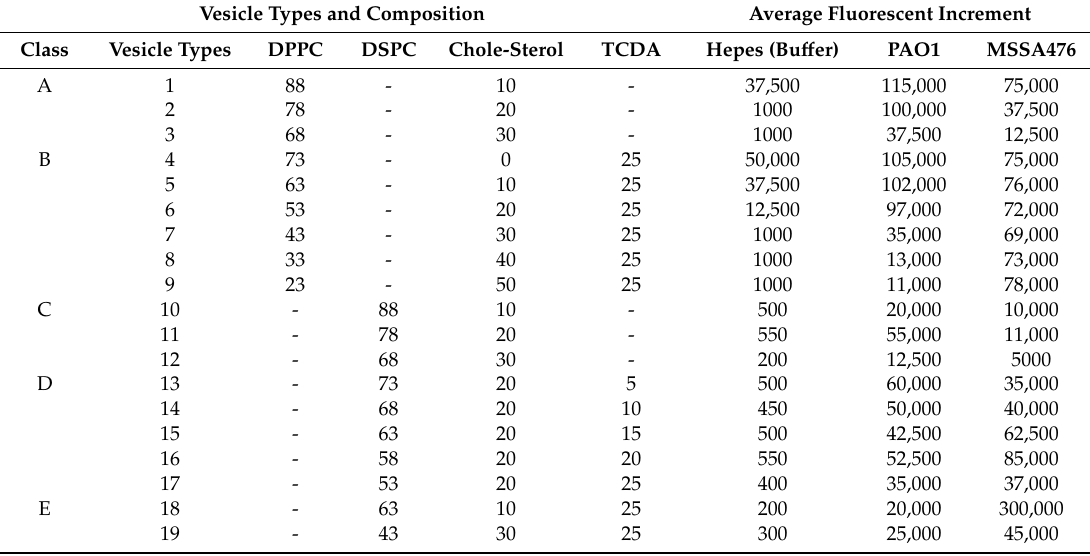
Table 6. Vesicle types, with mol % of the phospholipid / fatty acid content and average fluorescent increase in response to